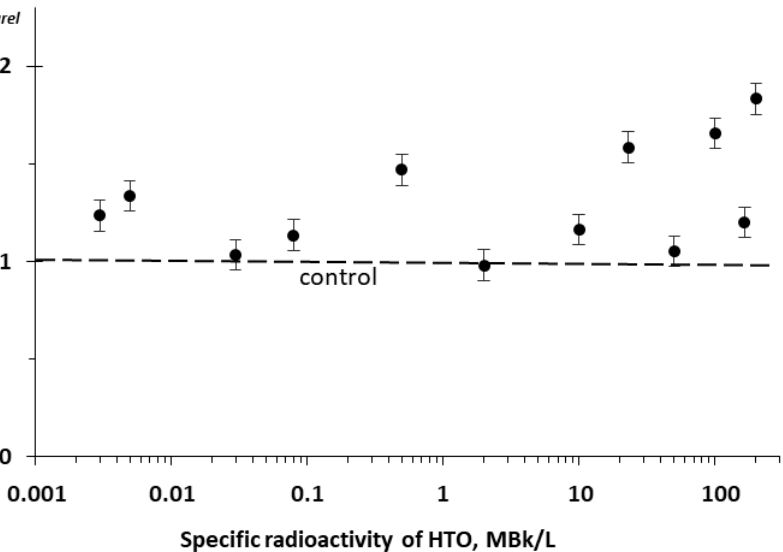
Figure 3. Relative bioluminescence intensity, I rel , of the coupled system of enzymatic reactions: bacterial luciferase–NAD(P):FMN-oxidoreductase vs. specific radioactivity of HTO at 20 min exposure.